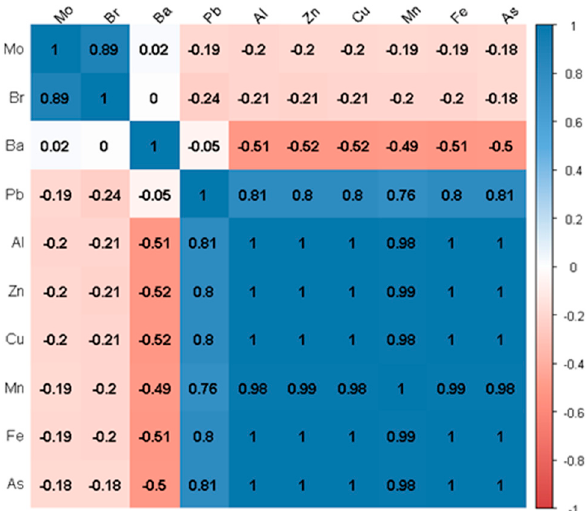
Figure 9. Surface and groundwater correlation matrix.